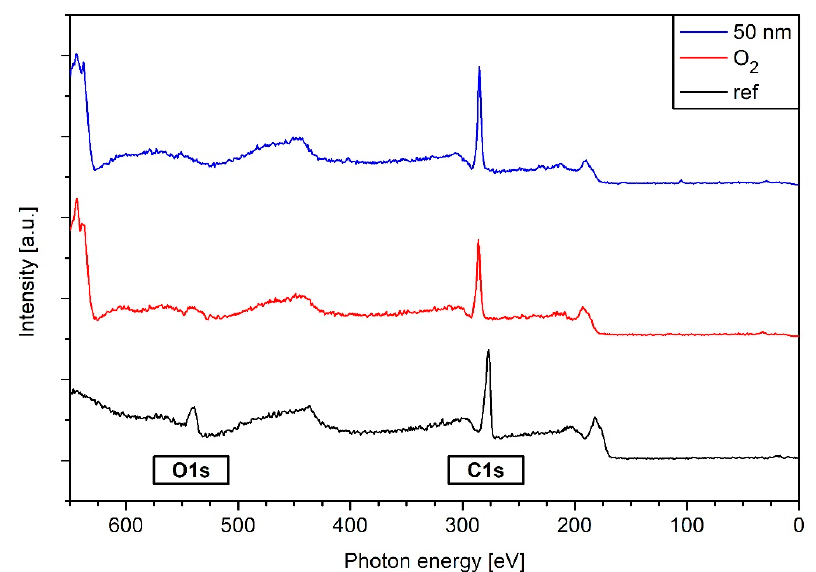
Figure 6. Full X-ray photoelectron spectroscopy (XPS) spectra of raw, O 2 treated and with a 50 nm a-C:H layer coated PHB. The disappearance for the O1s (532 eV) and shape changes in C1s (284 eV) are clearly visible.